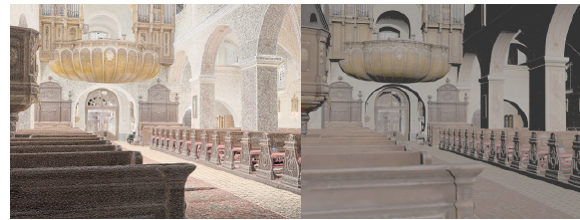
Figure 26. Interior section view of the Zápoľský chapel – drawing with